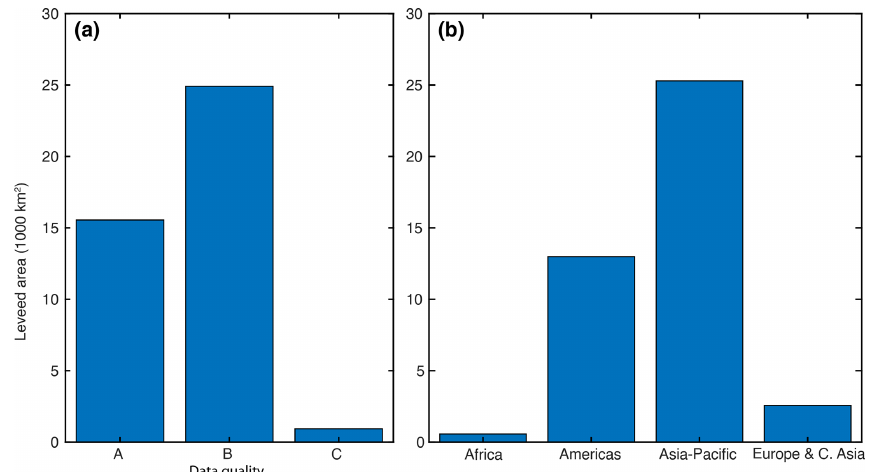
Figure 4. (a) Distribution of data quality classification in openDELvE given for each individual leveed area feature, classified according to the data quality matrix (Table 3). (b) Distribution of leveed area data in openDELvE by UN